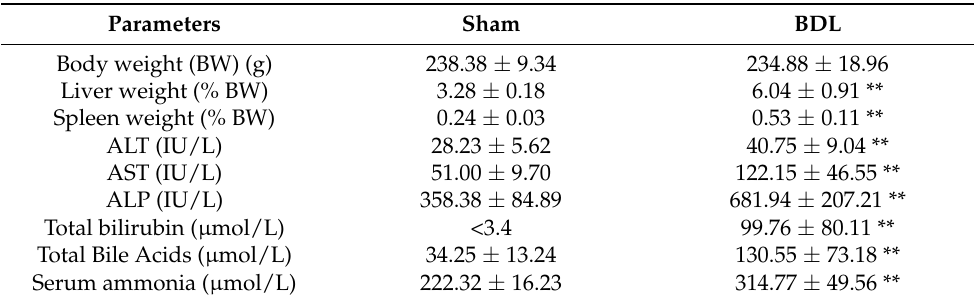
Table 1. Physiological and biochemical parameters of sham and BDL rats on the 14th day following